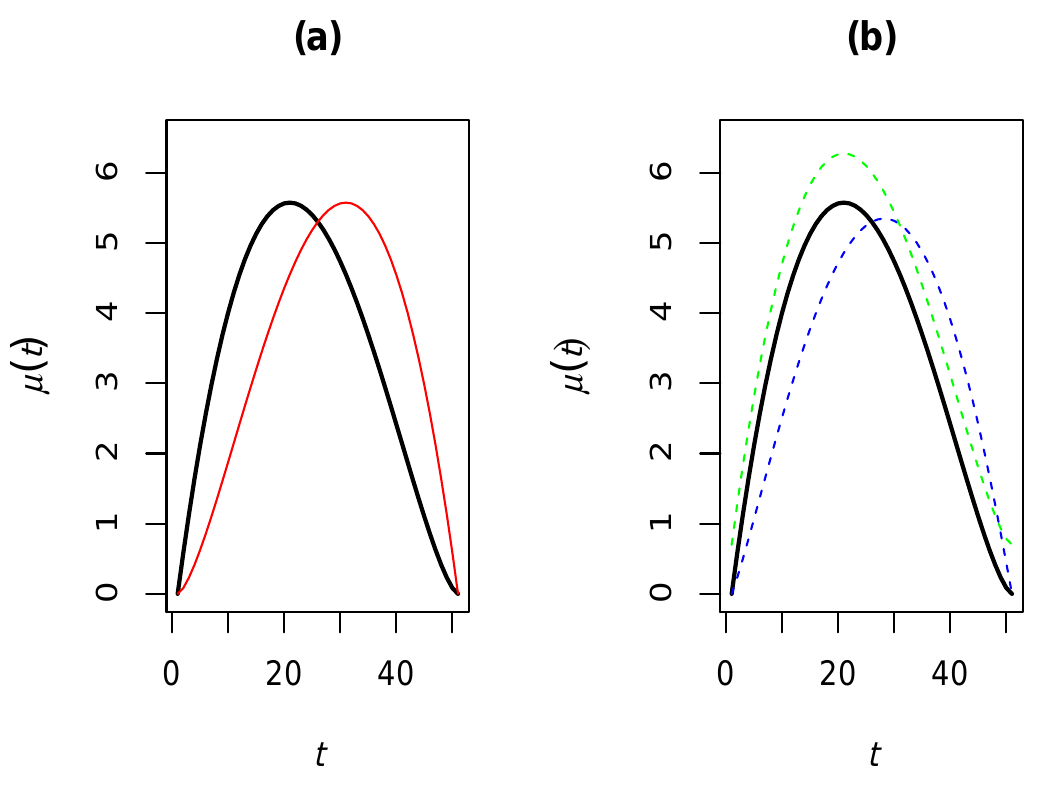
Figure 9. ( a ) Functional means and ( b ) changes in the shape and the magnitude in the mean of the